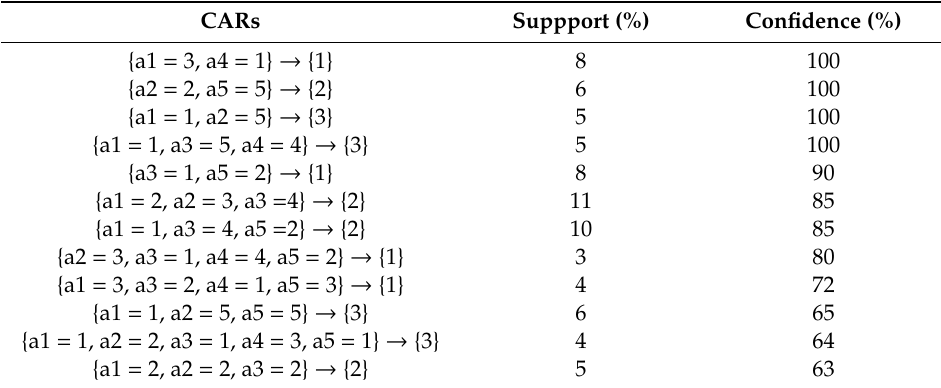
Table 3. Sorted class association